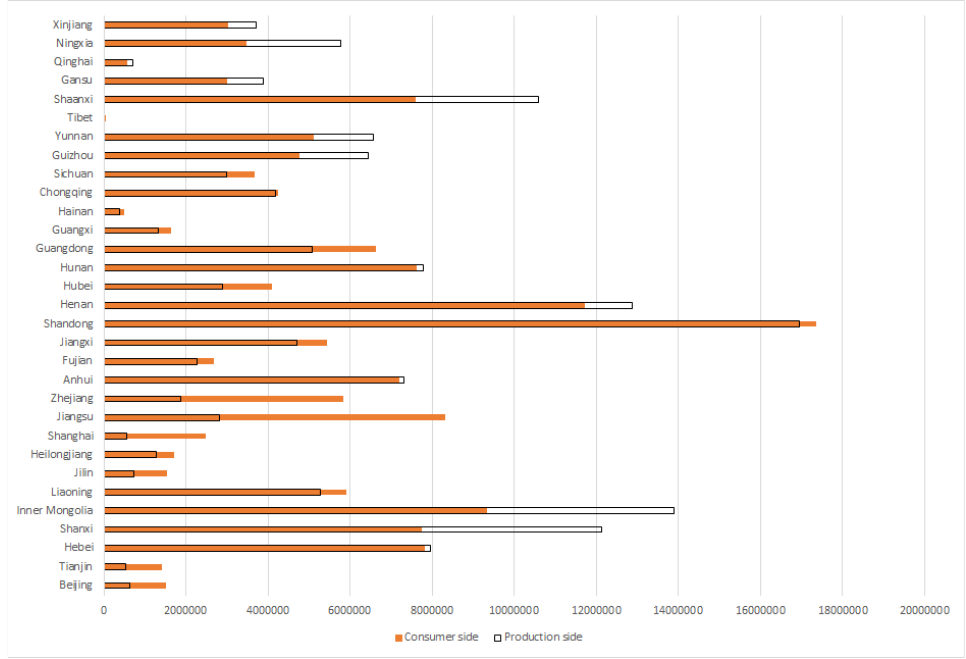
Figure 1. Accounting for SO 2 emissions from the production and consumption sides in 31 provinces and cities in